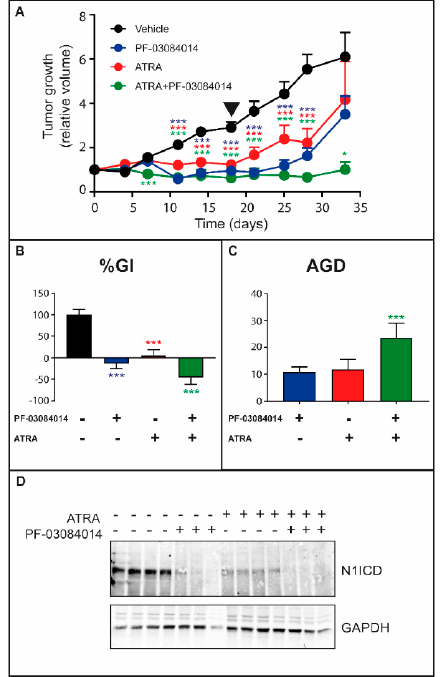
Figure 4. Anti-tumor effects of ATRA and PF-03084014 alone or in combination on the growth of HCC-1599 xenografts. HCC-1599 cells (1 × 10 7 /animal) were injected subcutaneously on the two